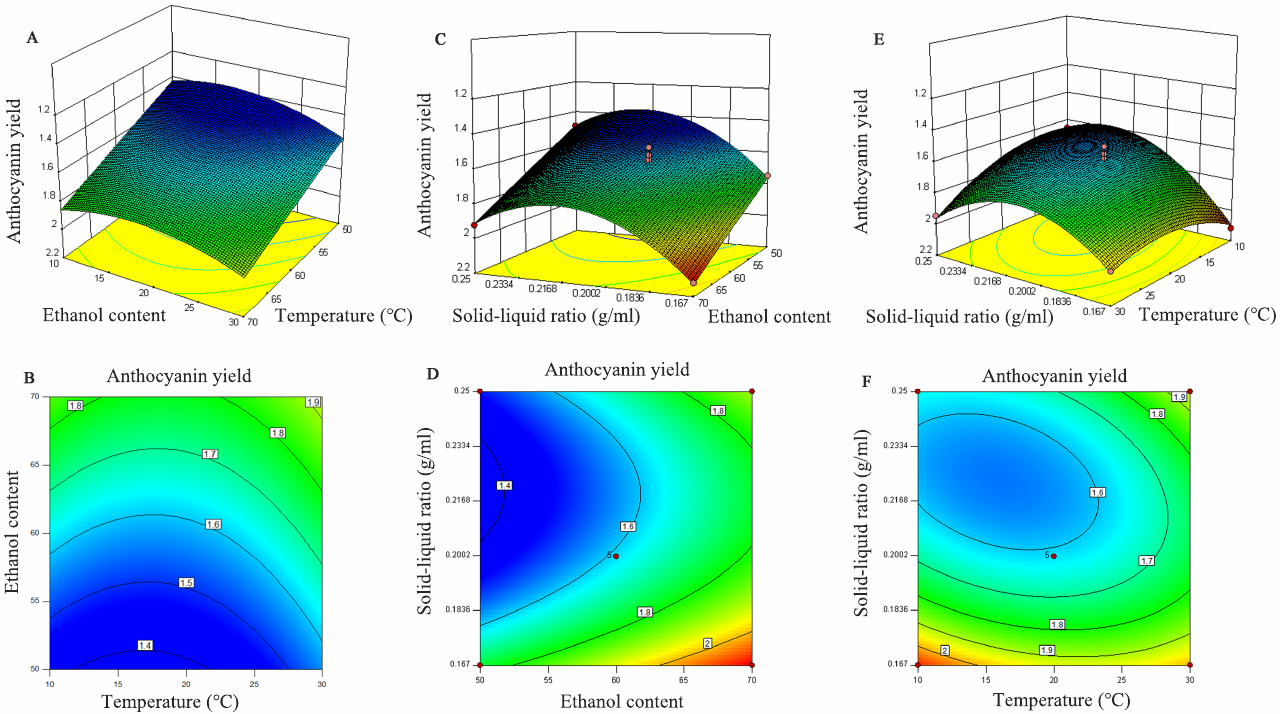
Figure 3. Three-dimensional response surface plots and corresponding contour plots. Influence of extraction ethanol content and temperature ( A , B ), solid–liquid ratio and ethanol content ( C , D ), and solid–liquid ratio and temperature ( E , F ) on anthocyanin yield from Malus ‘Royalty’ fruits.